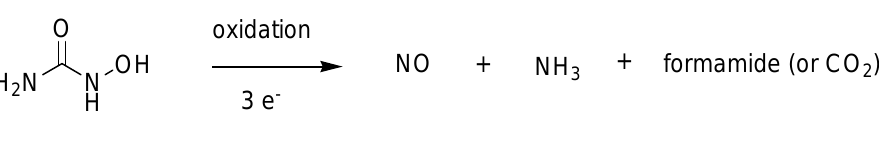
Figure 48 : Hydroxyurea oxidation to nitric oxide